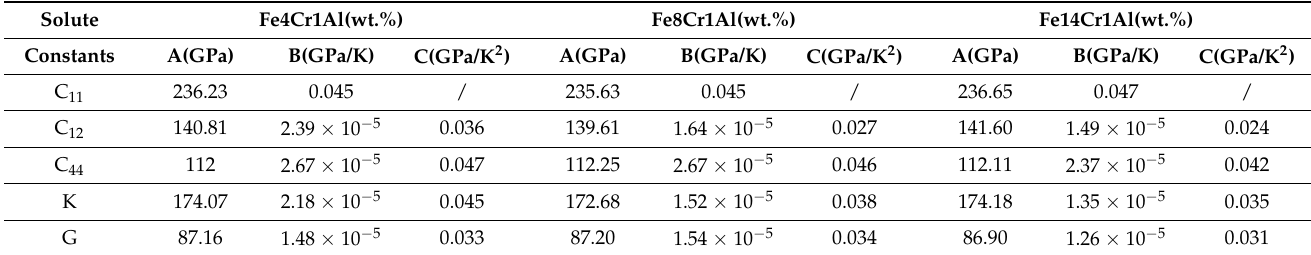
Table 2. Fitted parameter values in the models of elastic constants and modulus as a function of temperature for Fe4Cr1Al (wt.%), Fe8Cr1Al (wt.%) and Fe14Cr1Al (wt.%). The models are given in Equations (1) and